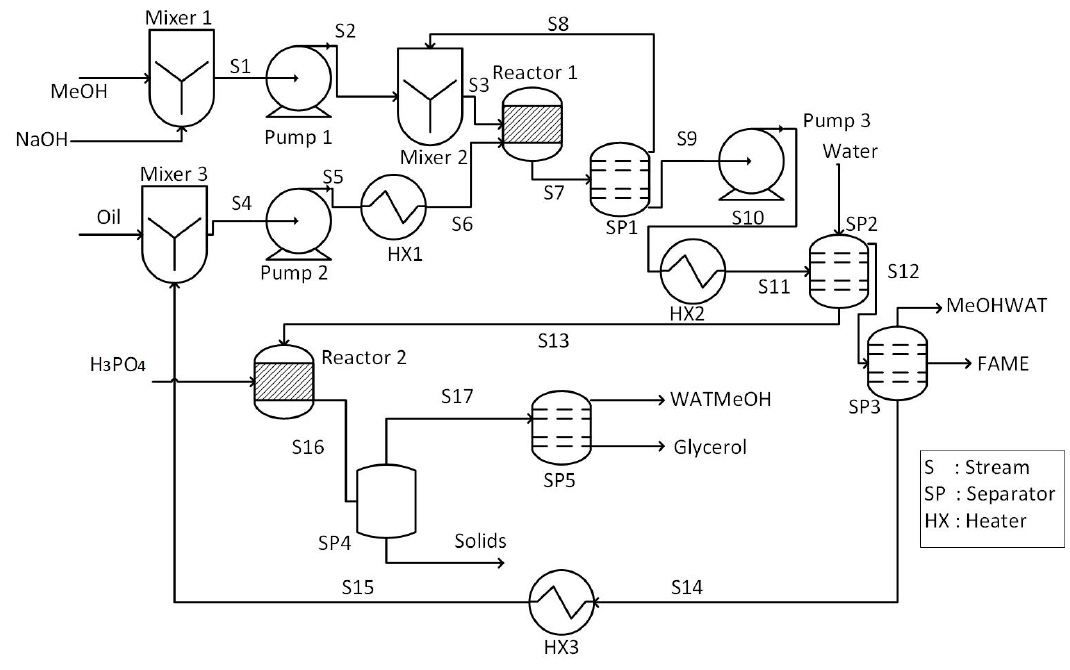
Figure 2. Process flowsheet of biodiesel production from vegetable